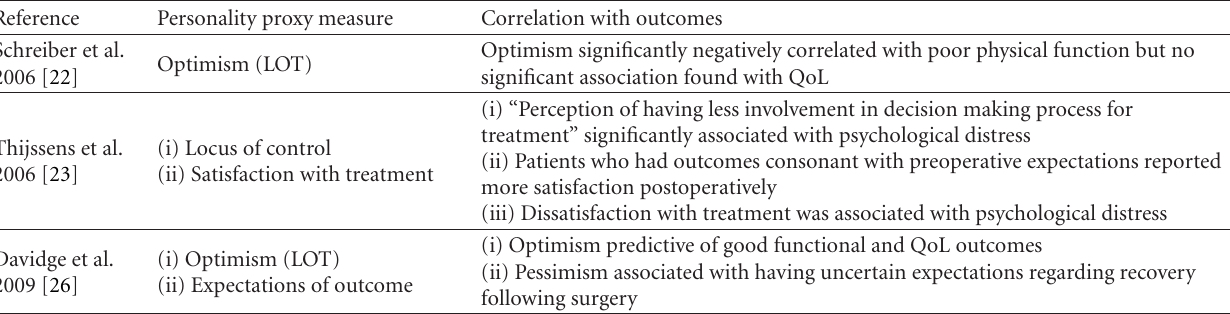
Table 7: Summary of personality characteristics.